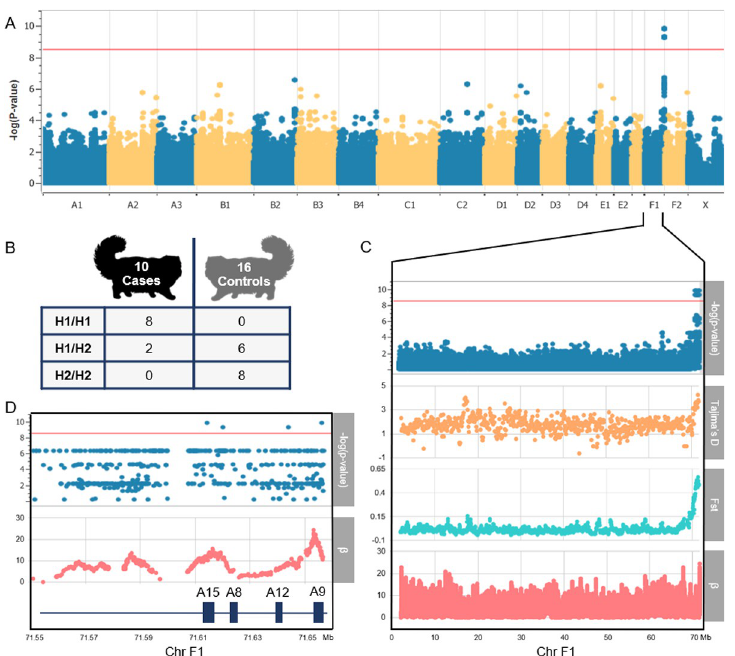
Fig 2. Genome-wide association analysis of Persians with and without severe dermatophytosis and evidence of divergent haplotypes under balancing selection. (A) Manhattan plot depicting single locus linear mixed model output for 10 Persian cat cases of severe dermatophytosis and 16 Persian cat controls. A locus on chromosome F1 achieves genome wide significance of p-value = 1.51x10 -10 . The Bonferroni-corrected significance threshold of p- value = 3.30 x 10 − 9 is shown in red. An additional Manhattan plot focused on the disease-associated locus can be found in S2 Fig. (B) Table depicting the genotypes of cases and controls for the disease-associated locus on F1. Two heterozygous controls are missing from the table as they were heterozygous for additional haplotypes (H3/H4 and H2/ H6). (C) A Manhattan plot depicting the entirety of chromosome F1 is shown along with Tajima’s D , Weir and Cockerham’s Fst, and the β statistic for detection of long-term balancing selection. (D) A regional Manhattan plot depicting the last ~100 kb of chromosome F1 is shown along with β and the gene annotation. Within the disease associated locus, β is most elevated over the S100A antimicrobial peptide genes, S100A9 (A9) and S100A15 (A15).